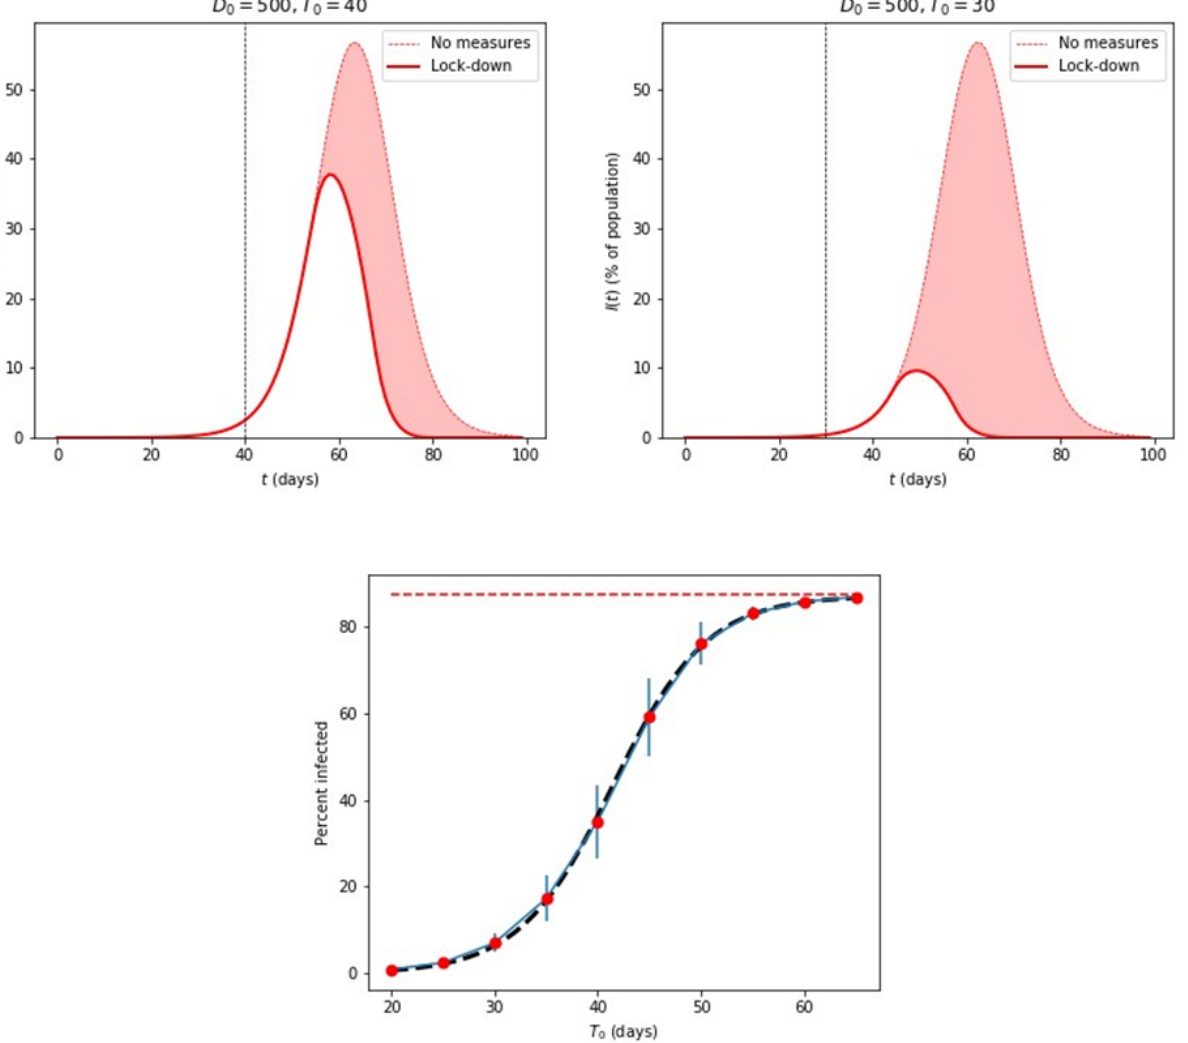
Figure 3. Top: Epidemic disease simulations of the infected population, I ( t ), as a percentage of the total population, using 1 million individual agents on a 2D grid, with different lockdown dates, T 0 , after the initial cases at t =0. The shaded curve in the background corresponds to I ( t ) with no lockdown measures. For these simulations, β =.25, 1/ γ = 14 days, and λ =2.5 days. Bottom: The percent of the total infected population, R tot ( T 0 ) for different values of T 0 , ranging from 0.93%, for T 0 =20 days, to 86.7%, for T 0 =65 days. The error bars represent standard deviations from averaging over 30 samples in each case (for the largest and smallest values, the error bars are too small to be visible). The black dashed curve is the fit from equation (4). The red dashed line represents the value for no lockdown measures, which is